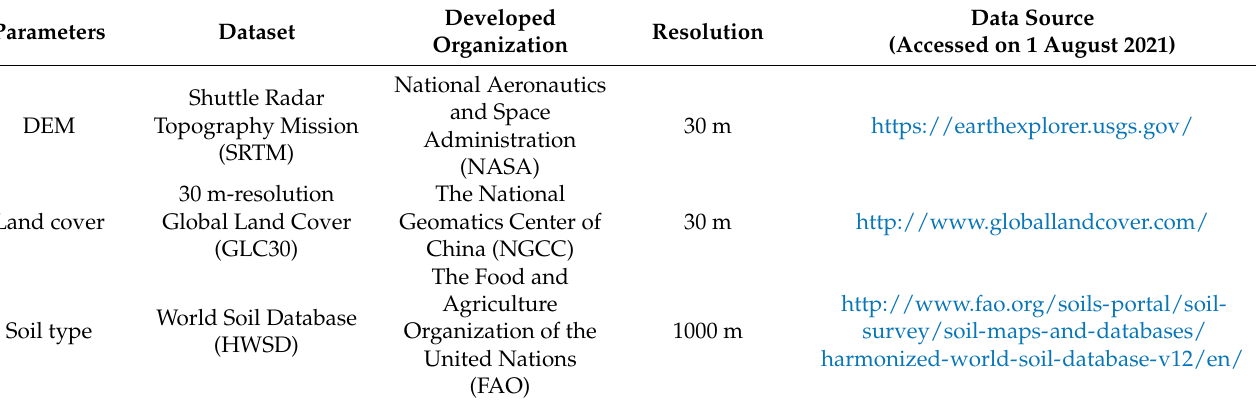
Figure 1. Location of the Danjiang River Basin and the distribution of hydrological stations, CMADS stations, TRMM points, and rain gauges. Table 1. Summary of the input